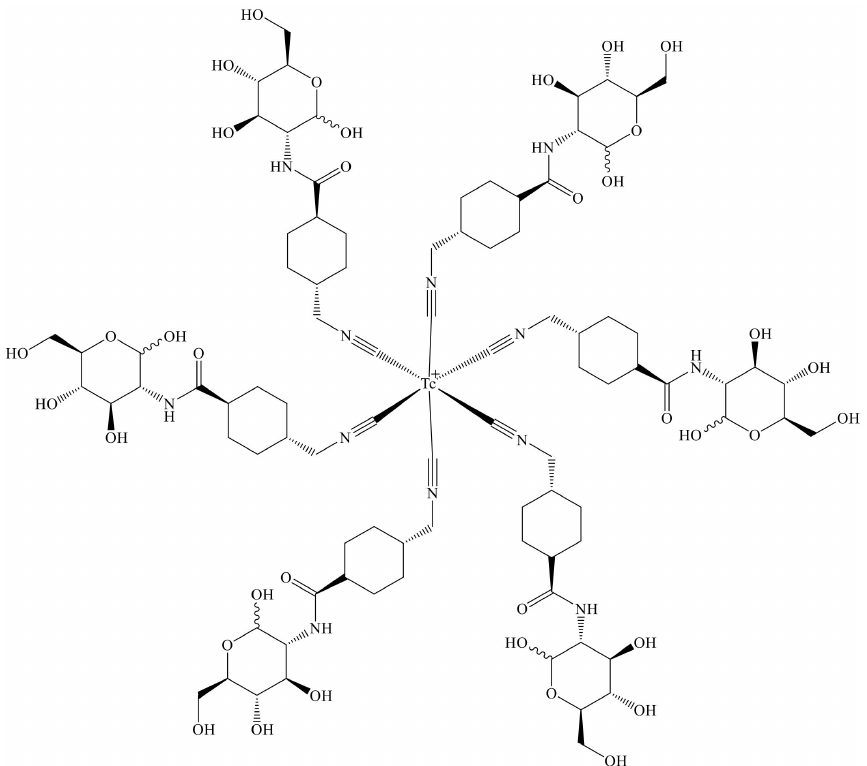
Figure 1. The proposed chemical structure of [ 99m Tc]Tc-CNMCHDG.